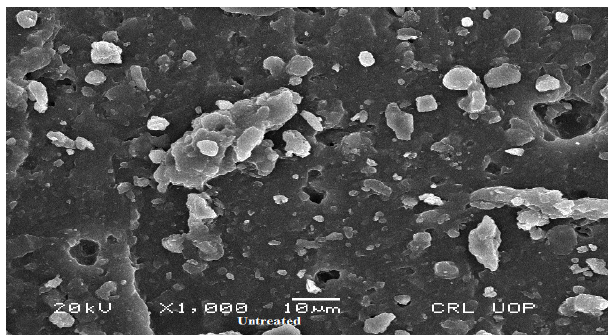
Figure 13. Untreated CR .